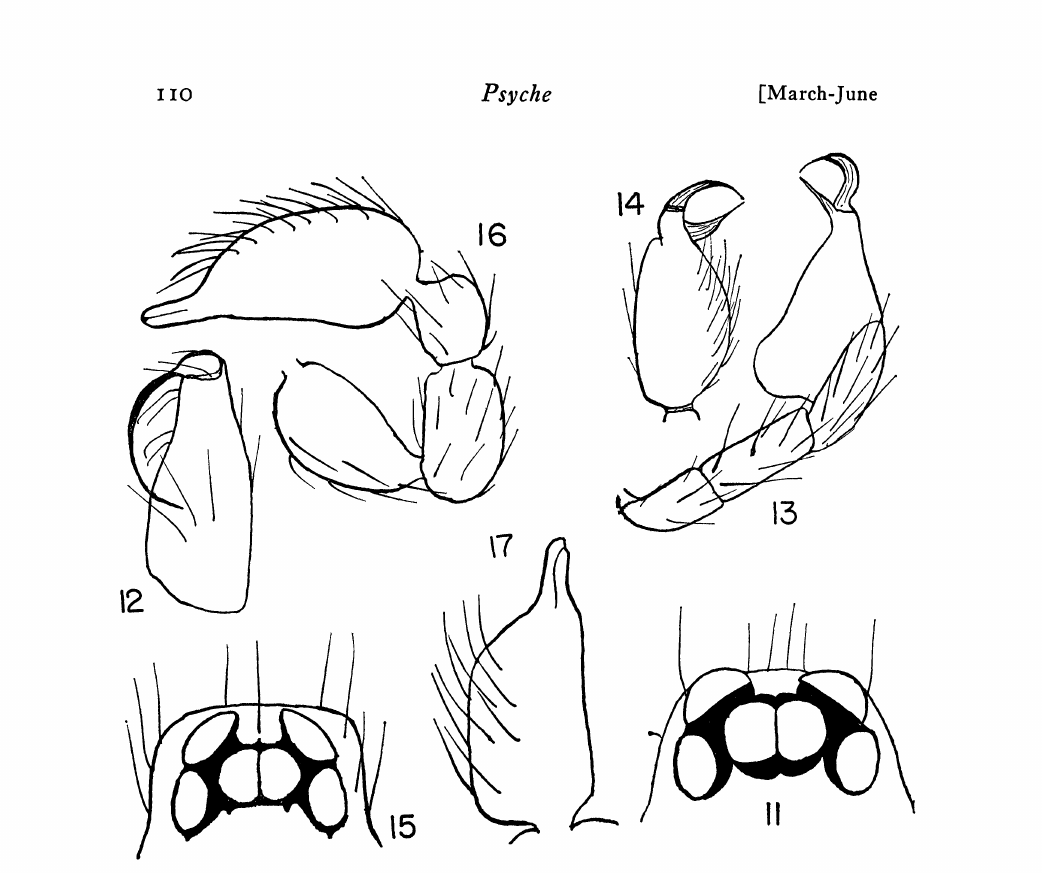
Figures 11-14. Oonops ebenecus sp. nov. Fig. 11. Eyes of holotype from above. Fig. 12. Left ehelieera from below. Fig. 13. Right palp of holotype; prolateral view. Fig. 14. Right palpal tarsus; nearly ventral view. Fig- ures 15-17. Oonops oblucus sp. nov. Fig. 15. Eyes ot holotype from above. Fig. 16. Left palp of holotype; retrolateral view. Fig. 17. Left palpal tar- sus of holotype; prolateral